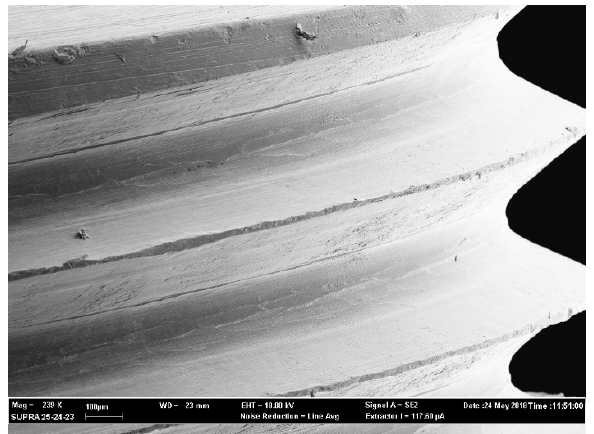
Figure 4. Air polishing and CHX treatment on a machined implant. Magnification 239×.